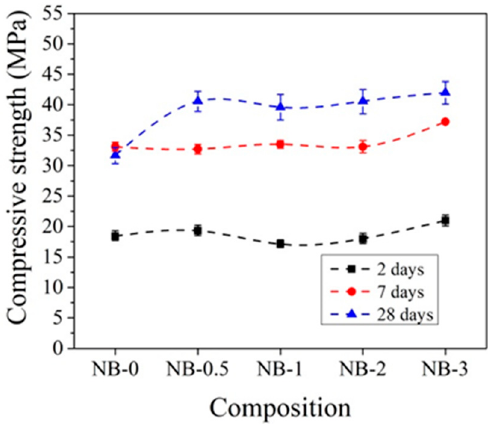
Figure 10. Compressive strength of concrete with CEM IIN samples at +20 °C curing.